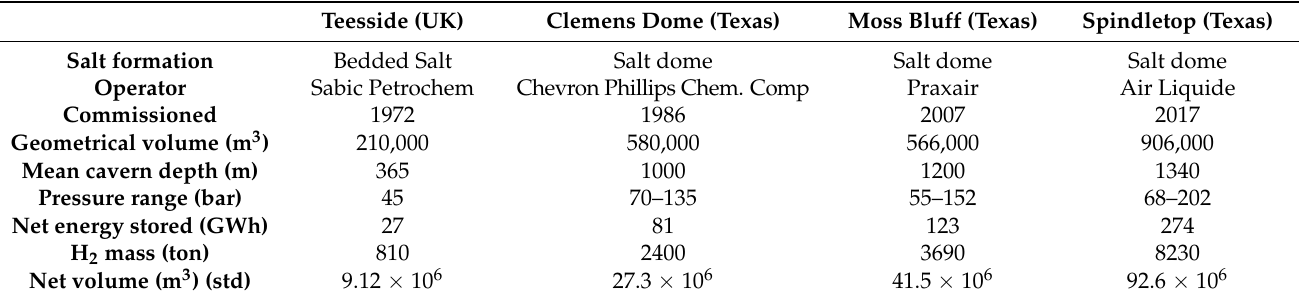
Table 1. Metrics of hydrogen caverns in the USA and the UK